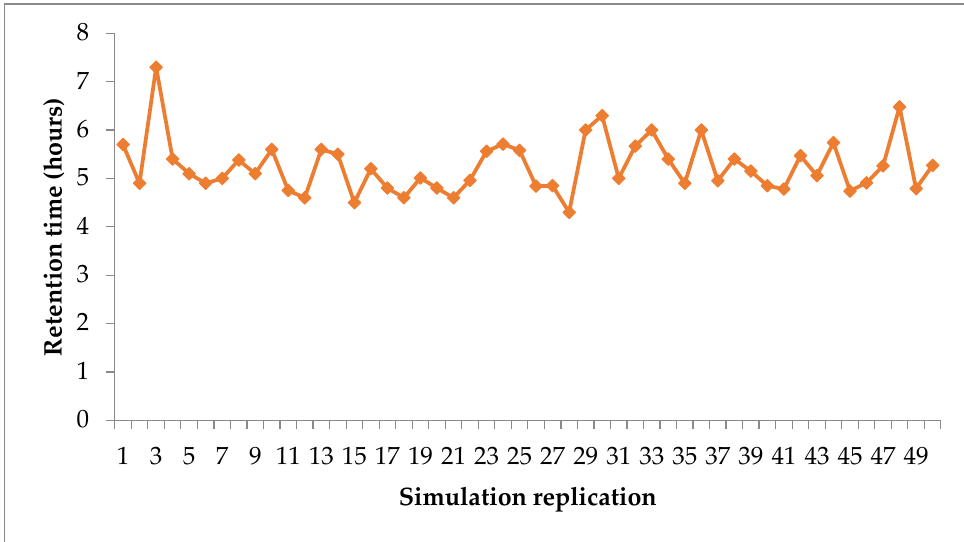
Figure 7. Average train retention time.